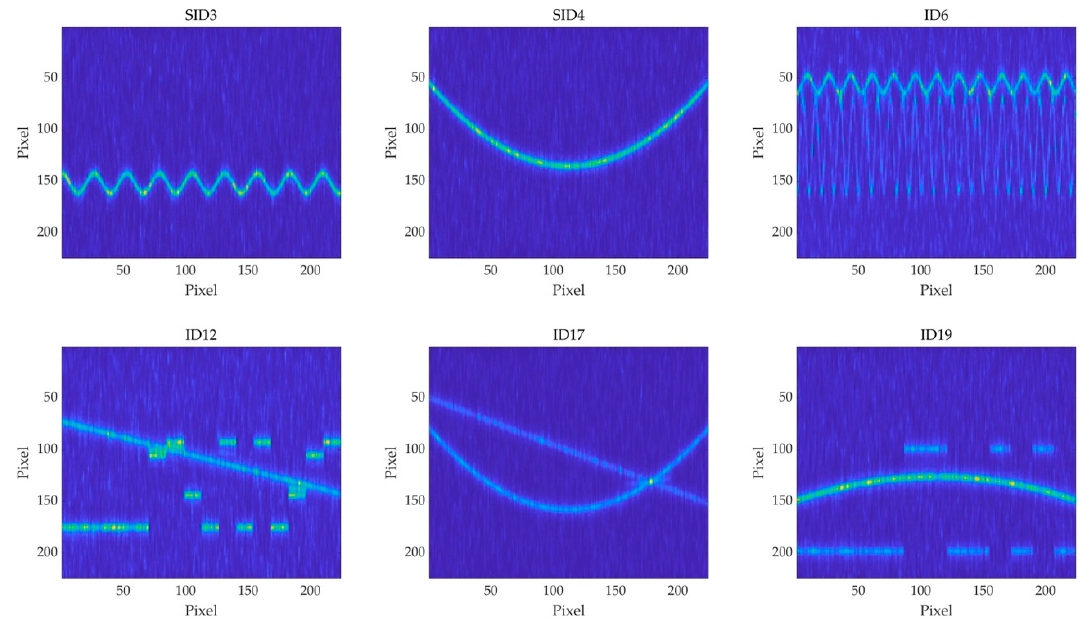
Figure 6. The TFIs of six modulation samples in SID3, SID4, ID6, ID12, ID17 and ID19 based on SPWVD when SNR is 0 dB.